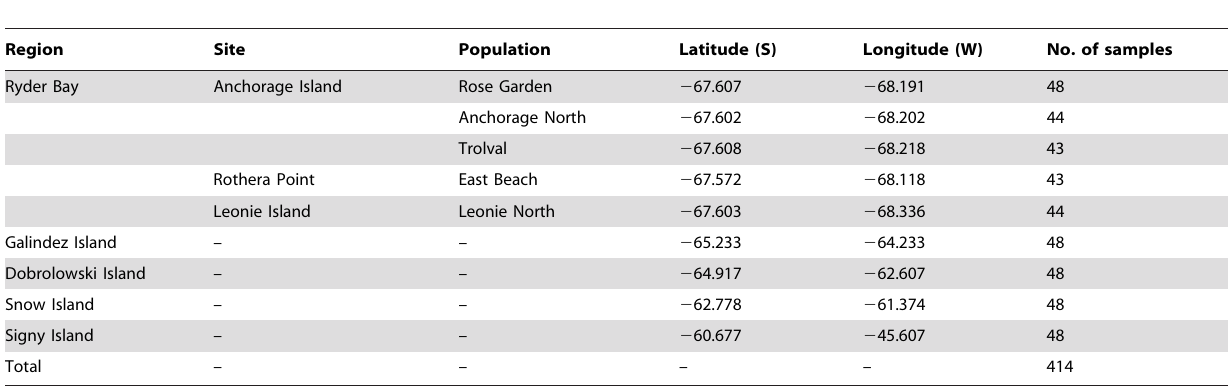
Table 1. Details of sampling locations and numbers of M. antarctica individuals collected, including 240 individuals previously sampled by Hoffman et al. [46].